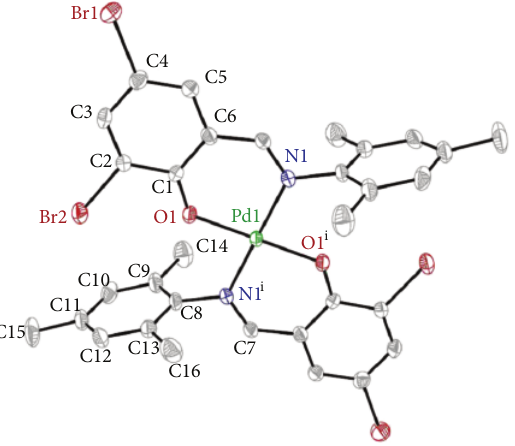
Figure 1: The molecular structure of compound 1 with numbering scheme (30% probability ellipsoids). All H atoms are omitted for clarity. Symmetry code: ( 𝑖 ) 2 − 𝑥 , 1 − 𝑦 , 2 − 𝑧